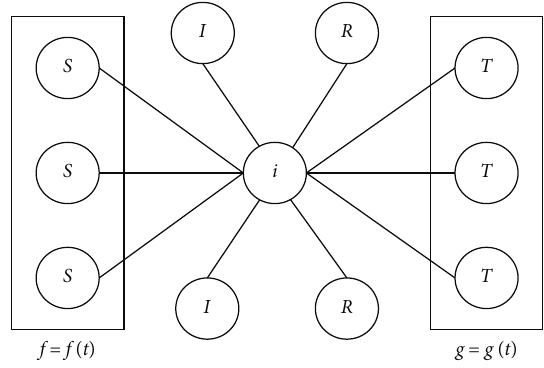
Figure 2: Ignorant node i connects other